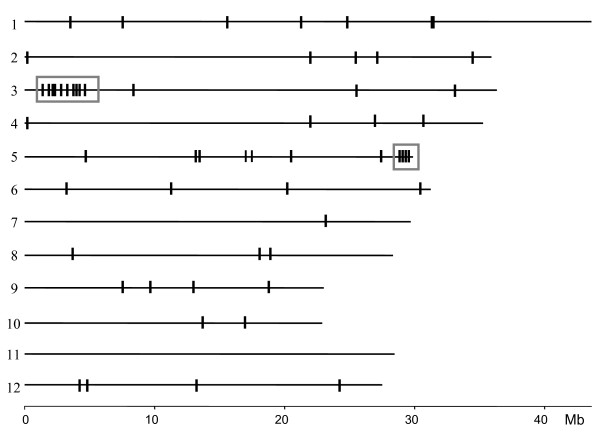
Rice orthologs of barley genes with single feature polymorphisms (SFPs). Rice genome display with rice orthologs (vertical bars) of barley genes which were polymorphic between Maythorpe and Golden Promise. These polymorphic loci were identified using the SFP analysis from the shoot dataset. Two rice gene clusters (boxed) on Chromosome 3 and 5 were identified from the SFP analysis.